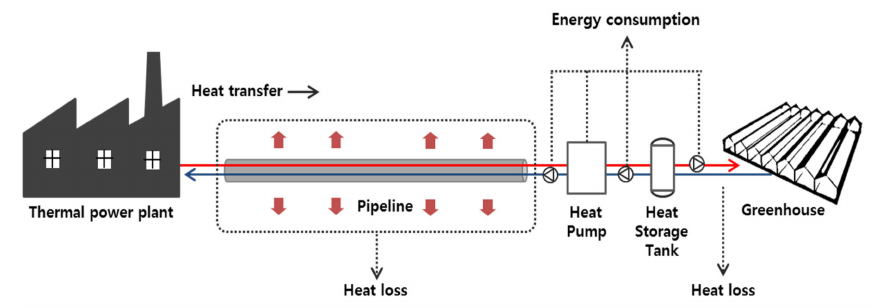
Figure 2. Structure of the analysis model and system diagram.